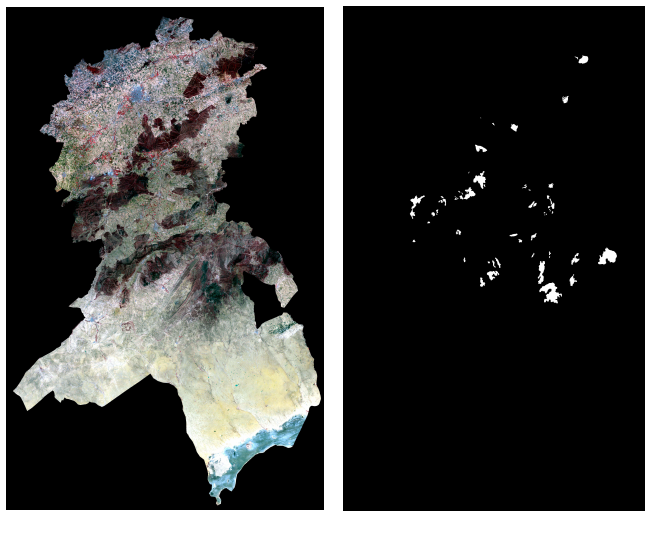
Figure 2. Landsat image used in our study and its associated ground